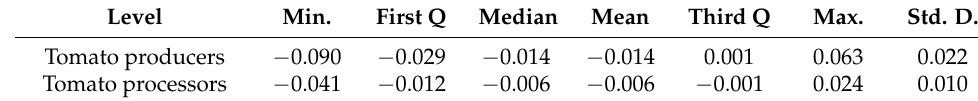
Table 3. The distribution of technological change. Source: authors’ calculations.